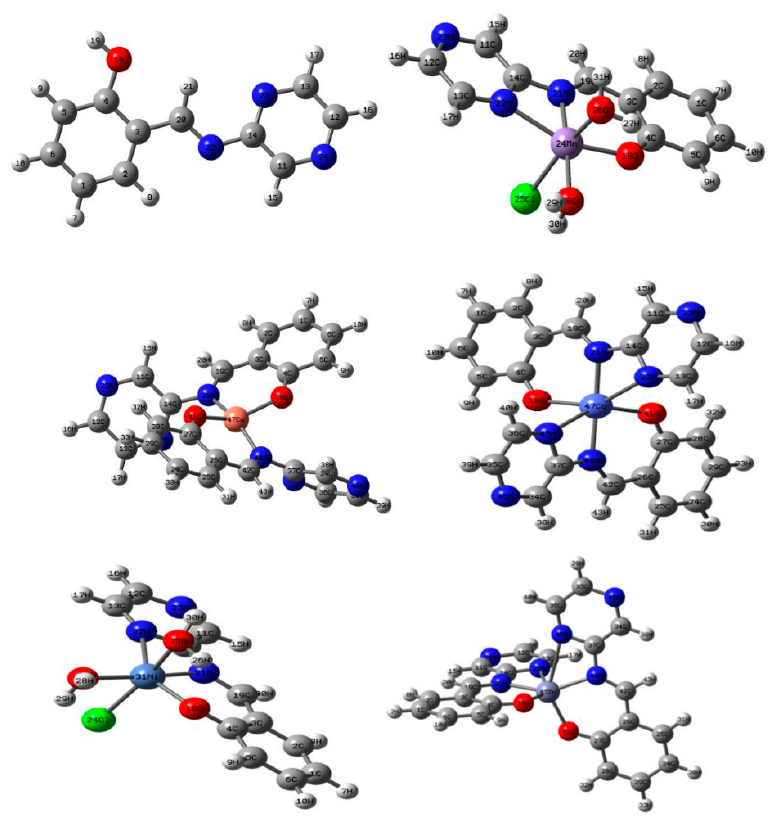
Figure 7. Optimized geometry, numbering system, and label for the Schiff base ligand and its complexes using